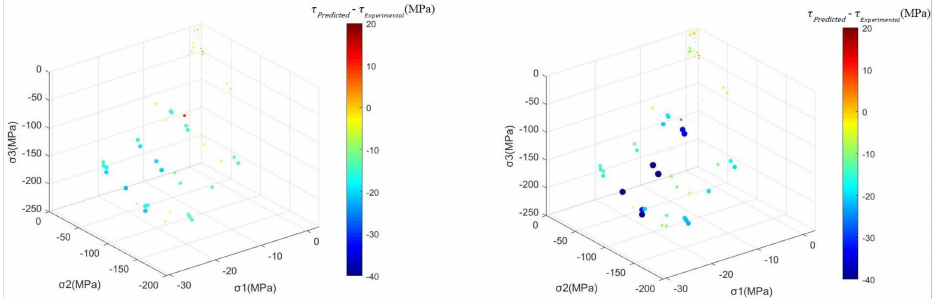
Figure 5. The error of Ottosen ( left ) and Guo Wang ( right )